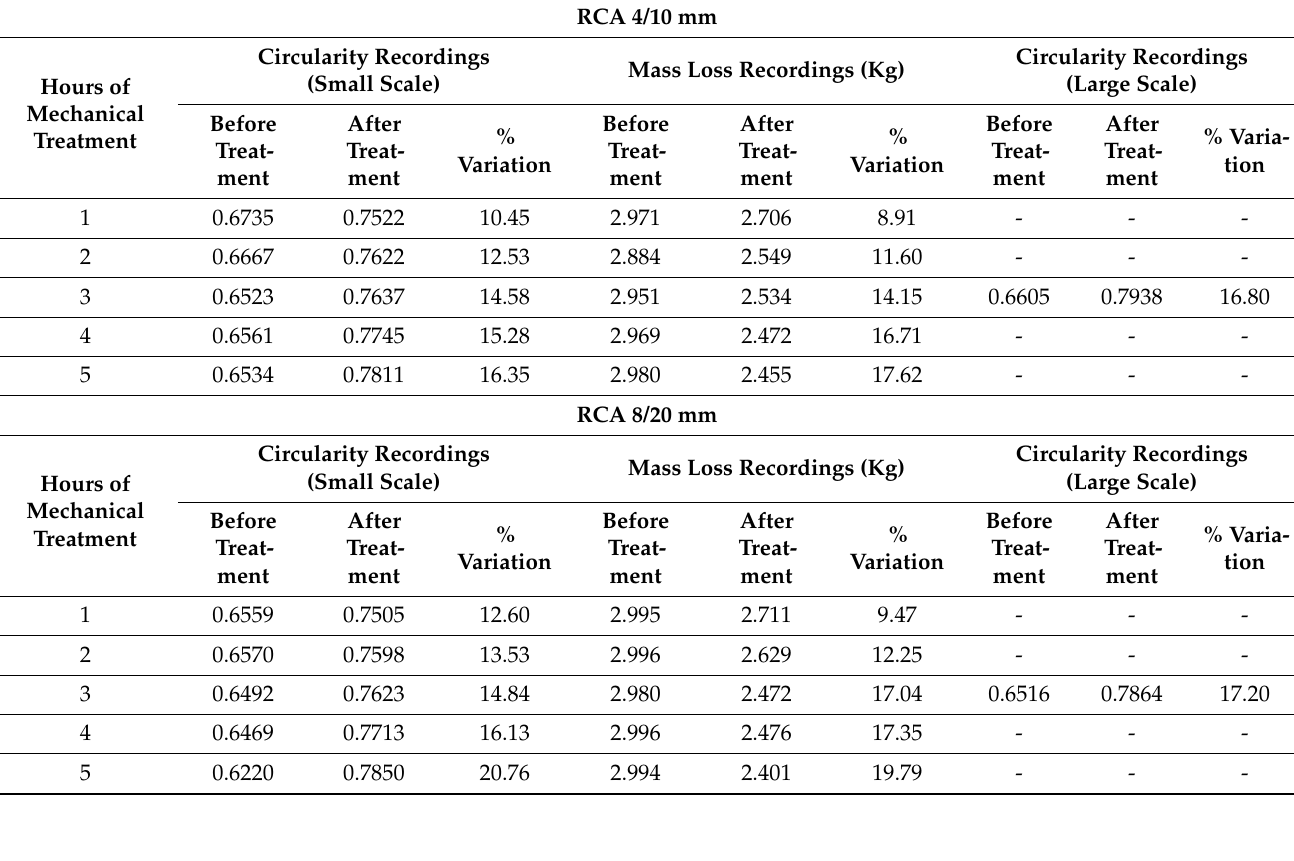
Table 4. Changes in geometry and mass of RCA subjected up to small-scale and large-scale treatment.